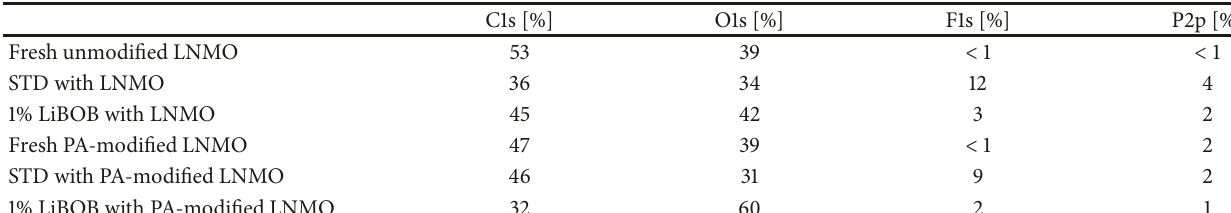
Table 2: Percentage cathode elemental concentrations from XPS.